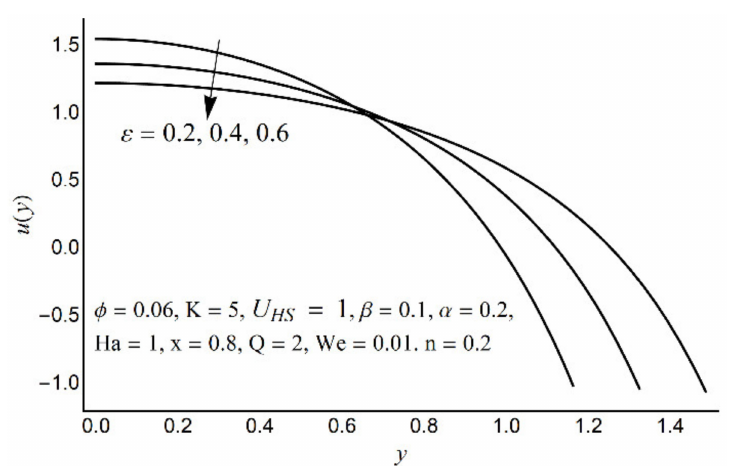
Figure 5. Axial velocity u ( y ) for various ε